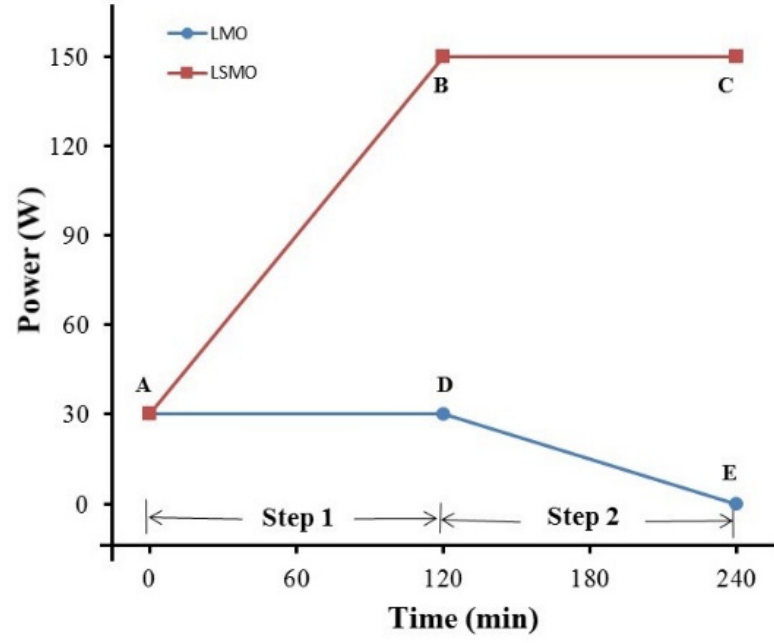
Figure 1. Schematic illustration of the specific deposition procedure of